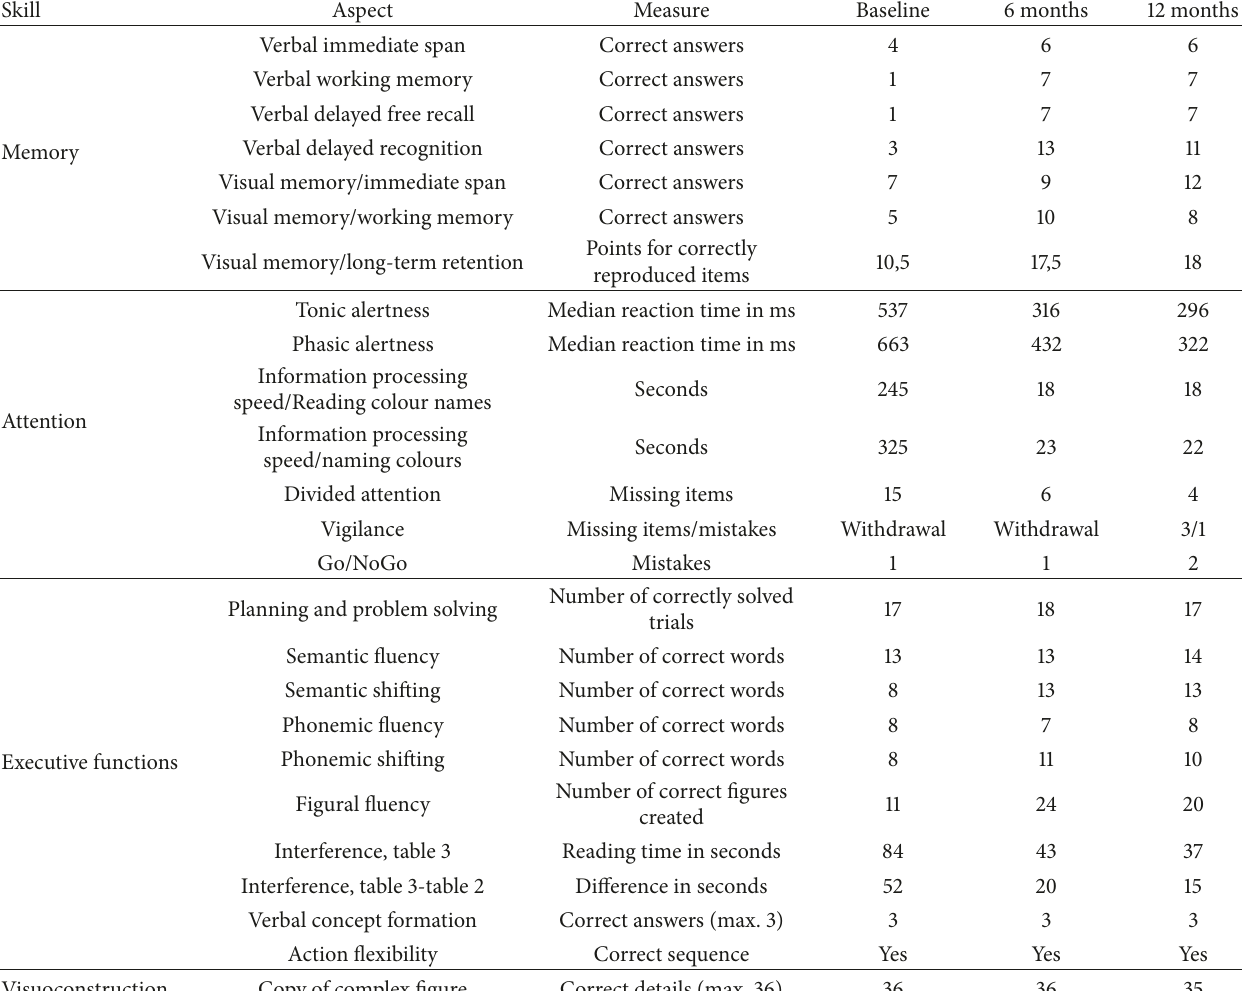
Table 1: Results at the three measuring points (raw